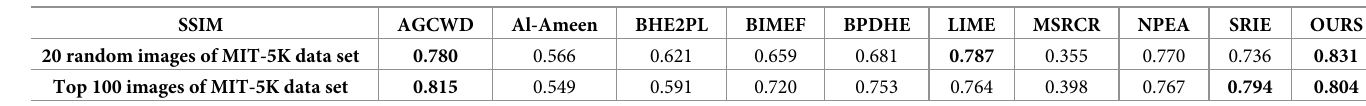
Table 6. Average SSIM of two groups of images of